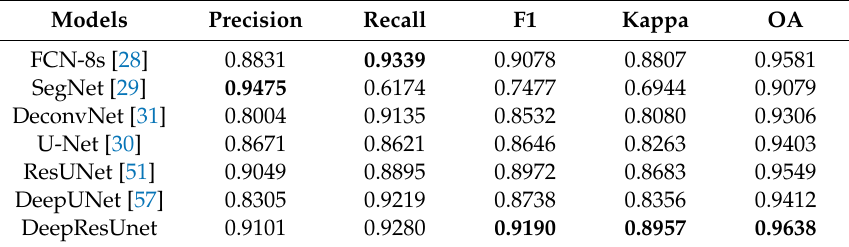
The bolded numbers indicate the largest number in the column, easier to find out which one performs better in this